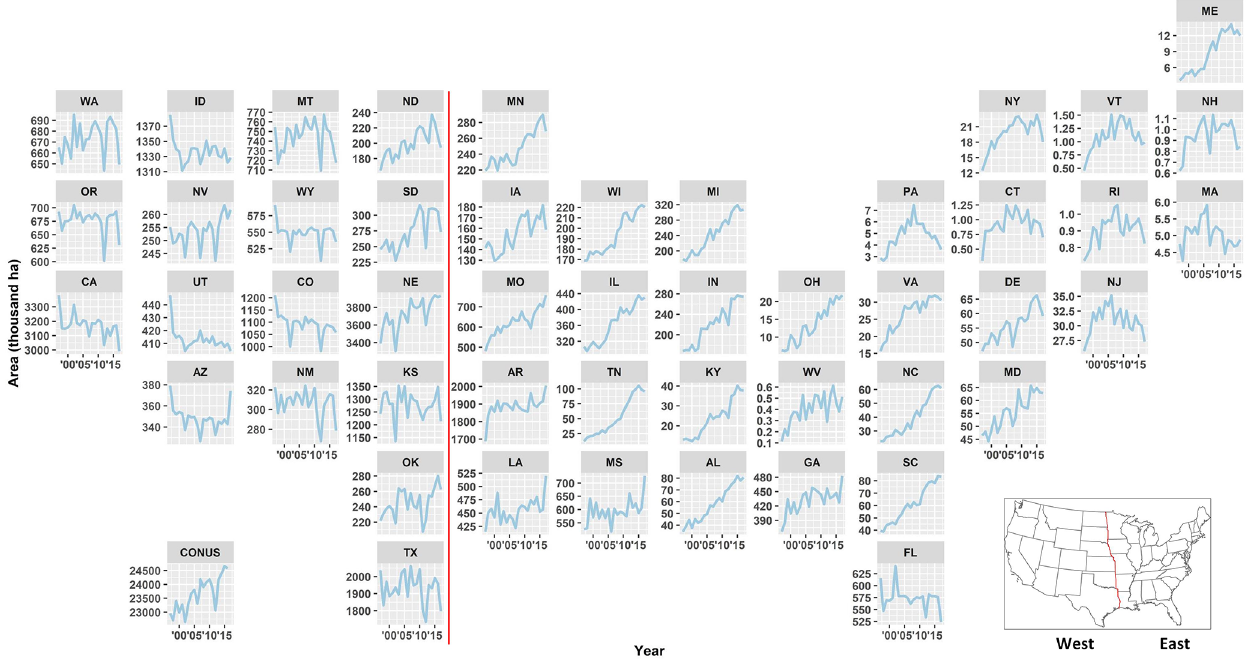
Figure 4. LANID-derived annual irrigation area by state, 1997–2017. The red line shows the east–west division in this study based on a climatic transition near the 100th meridian. Annual irrigation area per state is provided in Table A1.